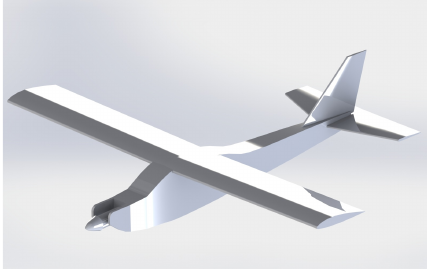
Figure 6. The 3D scanning of the Avistar UAV with the ZScanner 800.